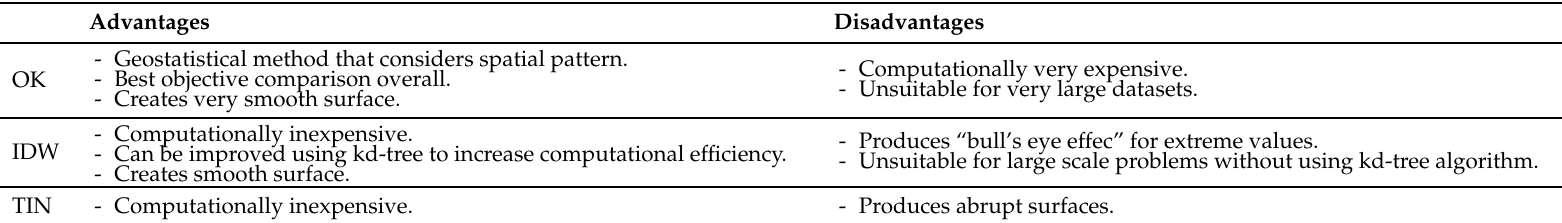
Table 5. Summary of the strengths and weaknesses of the spatial interpolation methods evaluated in this paper: ordinary kriging (OK), inverse distance weighting (IDW) and triangle irregular network (TIN). These evaluations are based on three criteria: objective performance (RMSE), computational efficiency and the final visual output